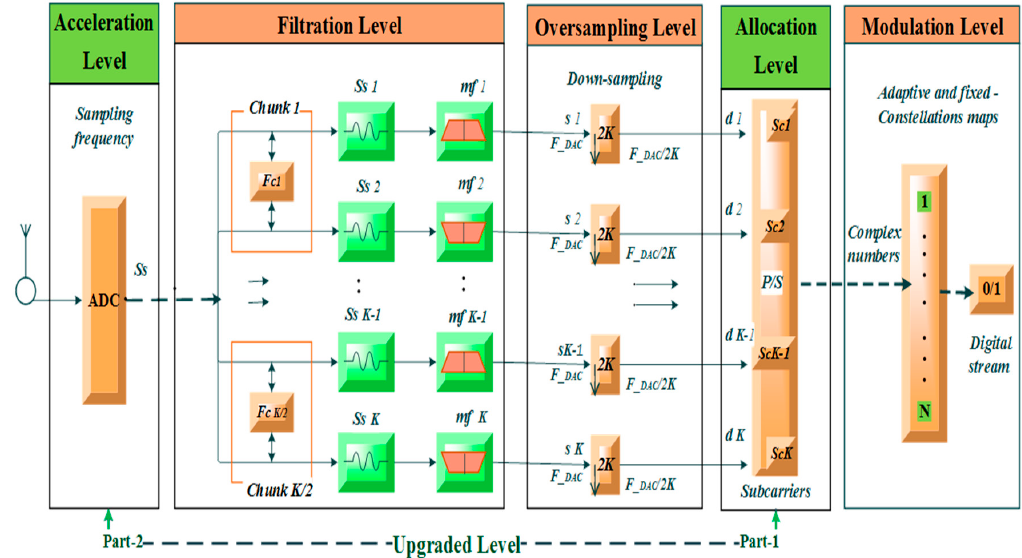
Figure 2. Receiver design of the OGFDM including the two key parts of the upgraded level.